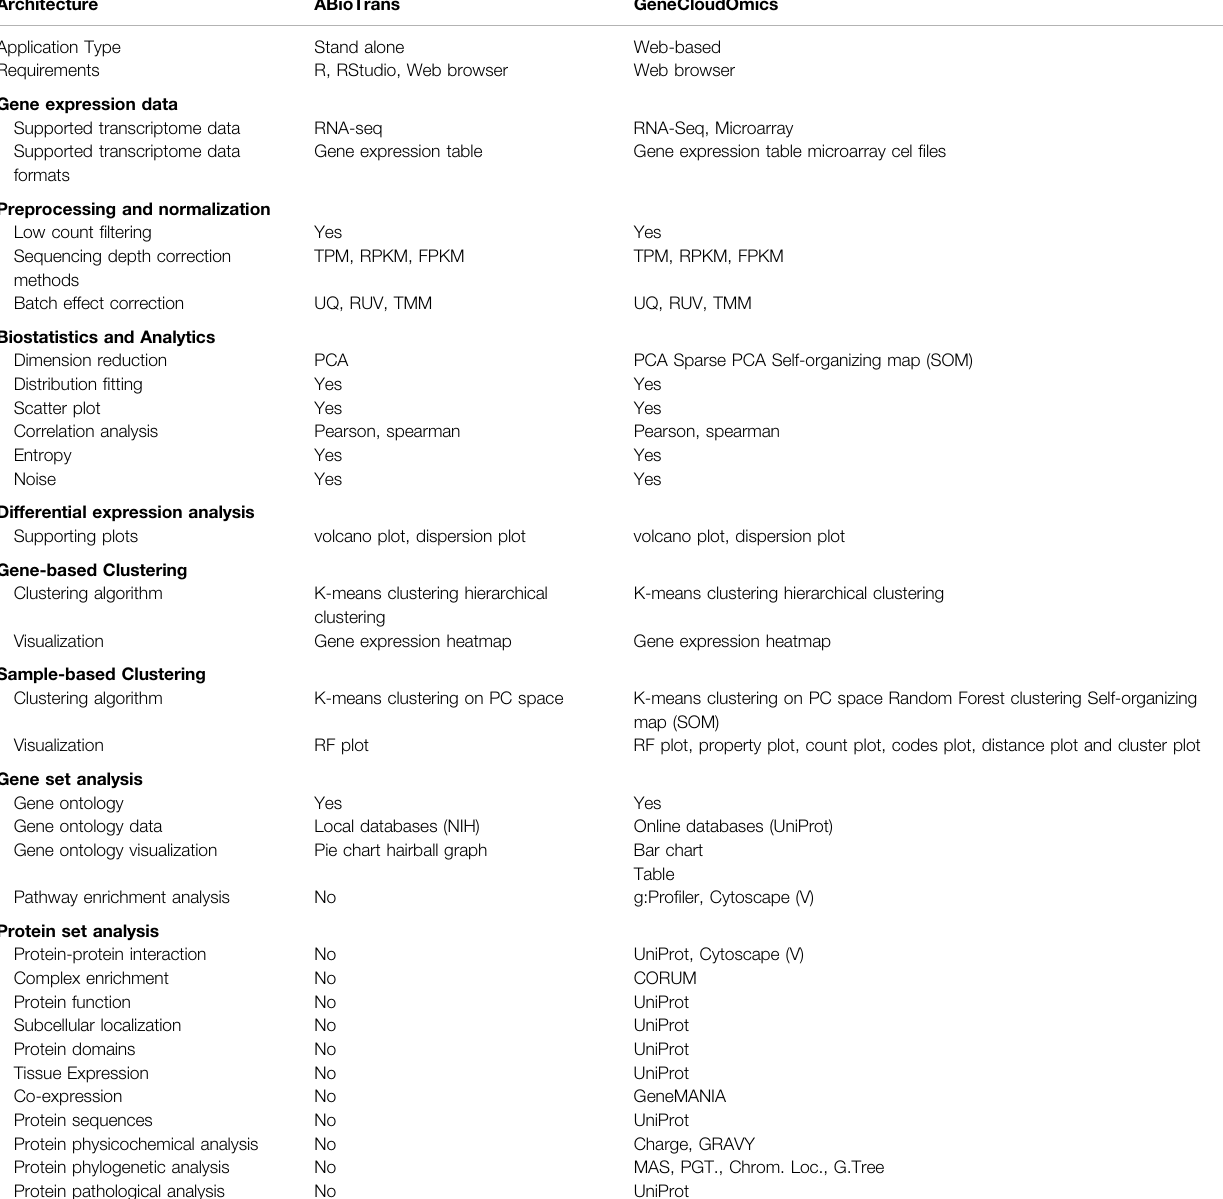
TABLE 2 | Features comparison between ABioTrans and GeneCloudOmics.